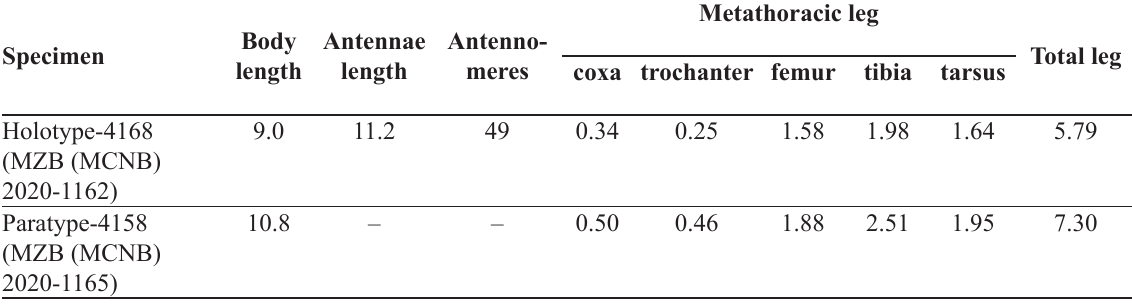
Table 3. Hubeicampa melissa Sendra & Lips gen. et sp. nov., length of the body, antennae and metathoracic leg, including their segments, and cerci (units in mm) as well as number of